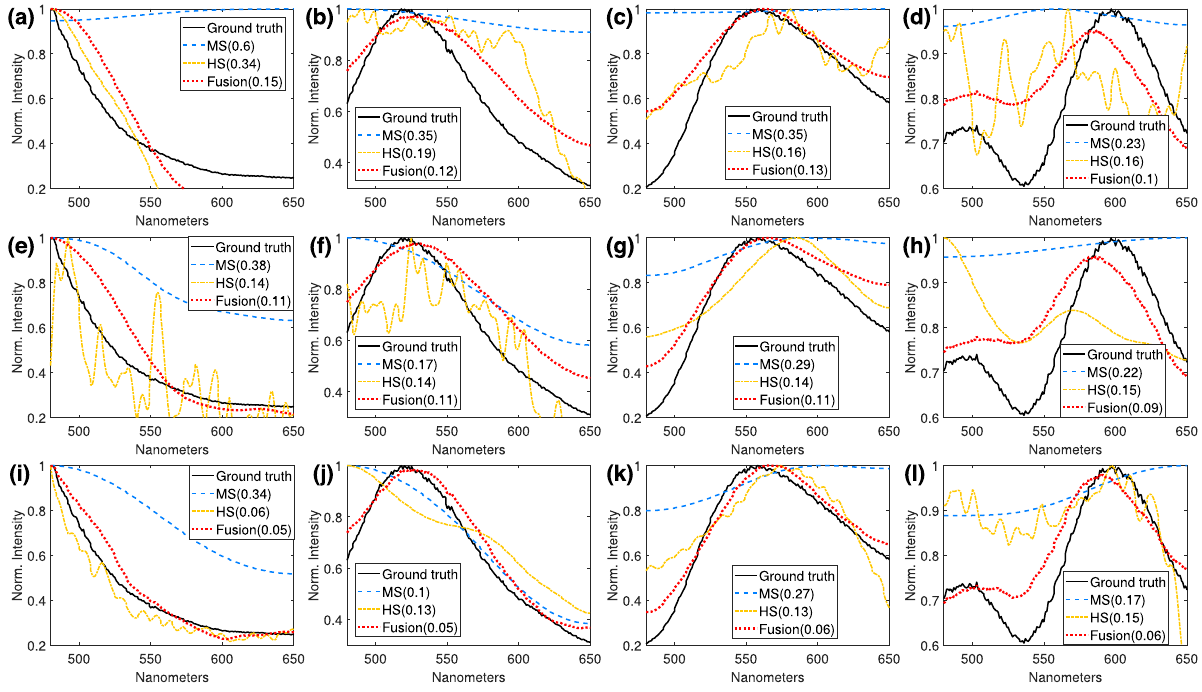
Figure 6. Analysis of the spectral reconstructions of the first target scene. Four different spatial regions (P1, P2, P3, and P4 in Fig. 4a) were measured with a spectrometer and compared against the reconstructed with the different methods and snapshots. ( a )–( d ) P1–P4 for K = 1 , ( e )–( h ) P1–P4 for K = 2 , ( i )–( l ) P1–P4 for K = 4 snapshots. This figure was created with Matlab R2019b, https:// www. mathw orks. com/ produ cts/ matlab. html, from data acquired with our imaging